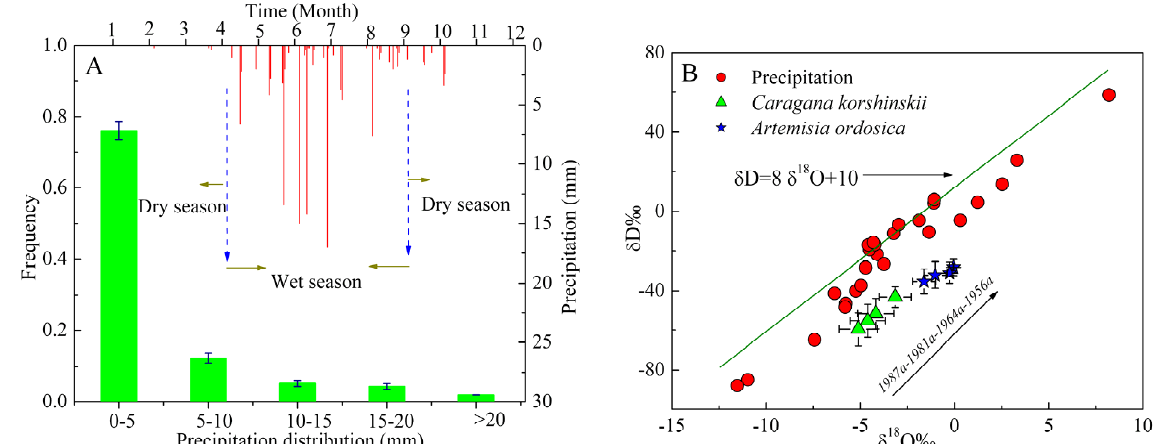
Figure 1. Precipitation and precipitation distribution in 2013 ( A ) The relationship of δ D and δ 18 O in rainwater (PPT) ( n = 25) and average xylem water in different revegetated sites in 2013; and ( B ) (mean ± SE, n = 63). The four revegetated sites were listed next to the symbols for plant stem